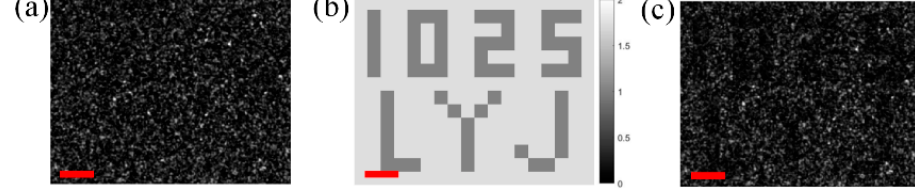
Figure 6. ( a ) Intensity (amplitude) distribution of the illumination wave. ( b ) Amplitude of the object. ( c ) Amplitude of the reflected wave. Scale bar: 550 μ m. ( c ) Amplitude of the reflected wave. Scale bar: 550 µ